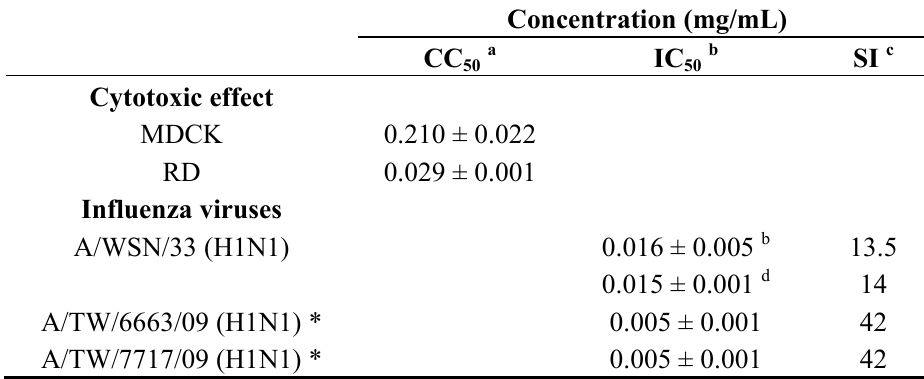
Table 1. Inhibition spectra of EAex against clinical isolated influenza virus and oseltamivir-resistant